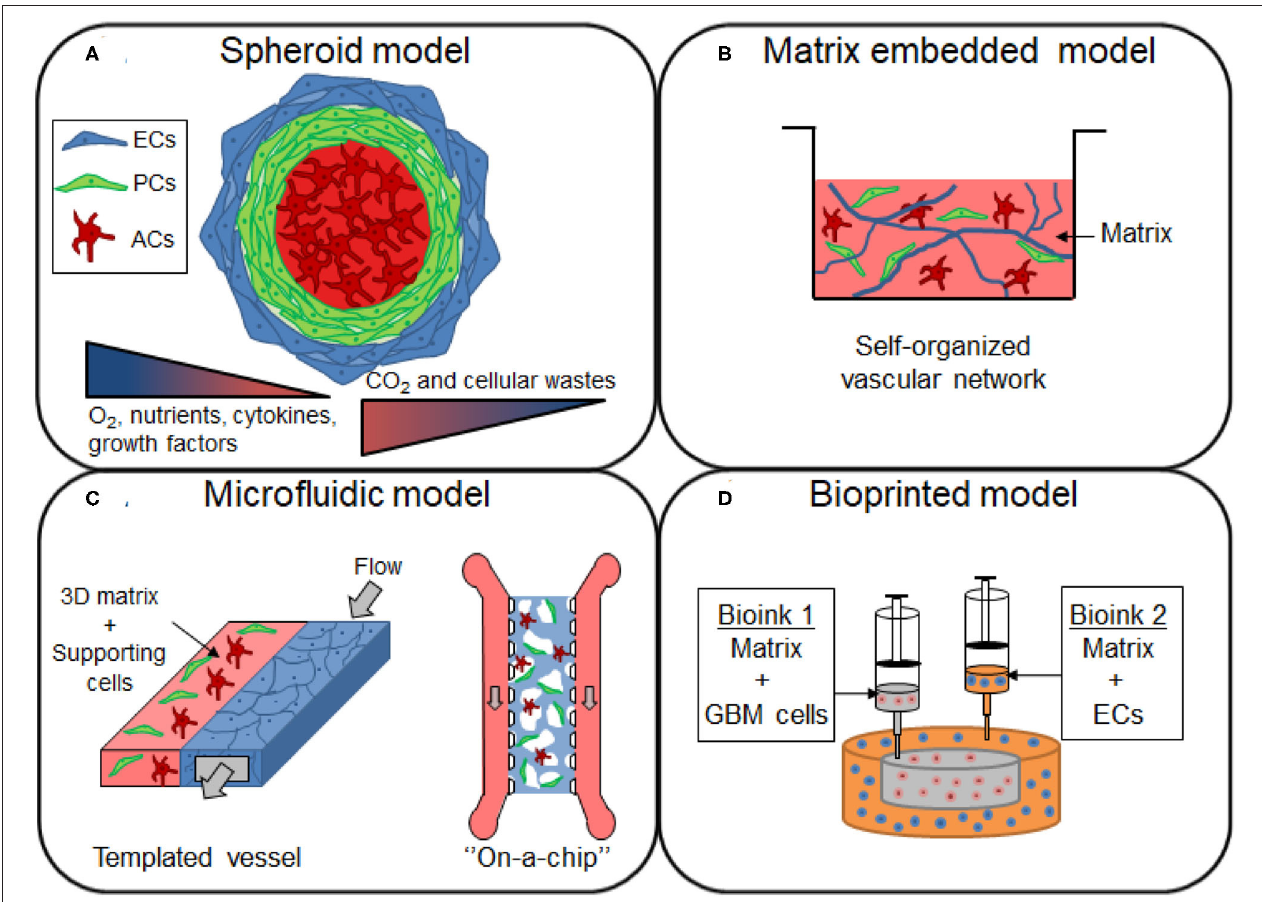
FIGURE 2 | Overview of the different 3D models of brain vasculature. (A) Spheroids are formed by the aggregation of single or multiple cell types from the BBB. The cells from the BBB can self-organized within the 3D structure, with endothelial cells (ECs) and pericytes (PCs) localized in the periphery, and with astrocytes (ACs) forming the core of the spheroid. Cells proliferation induce an increase in size of the spheroid, establishing gradients of nutrients, oxygen (O 2 ), carbon dioxide (CO 2 ) and cellular wastes. (B) Cells of the BBB are mixed in a matrix made of native or synthetic materials to provide a scaffold that support cell migration and the formation of a self-organized vascular network, with sometimes the presence of lumen. (C) In microfluidic devices, the blood flow is simulated by the injection of the medium inside the channel of the device. The generated shear stress enhances the barrier functions of the blood vessel, restricting the permeability of the molecules. (D) Construction of glioblastoma (GBM) model by bioprinting method. A compartmentalized structure with GBM cells in the core and ECs in peripheral regions can be achieved by sequential deposition of various bioink